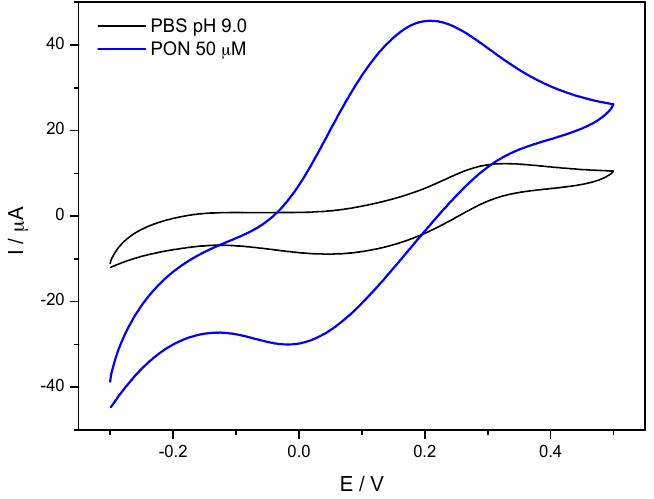
Figure 7. Cyclic voltammograms of poly(2,6-DHN)/SPCE in 0.1 M PBS pH 9.0, in the presence (bue line) and absence (black line) of 50 µ M PON. Potential range: − 0.3 V to +0.5 V; scan rate: 100 mv · s − 1 .